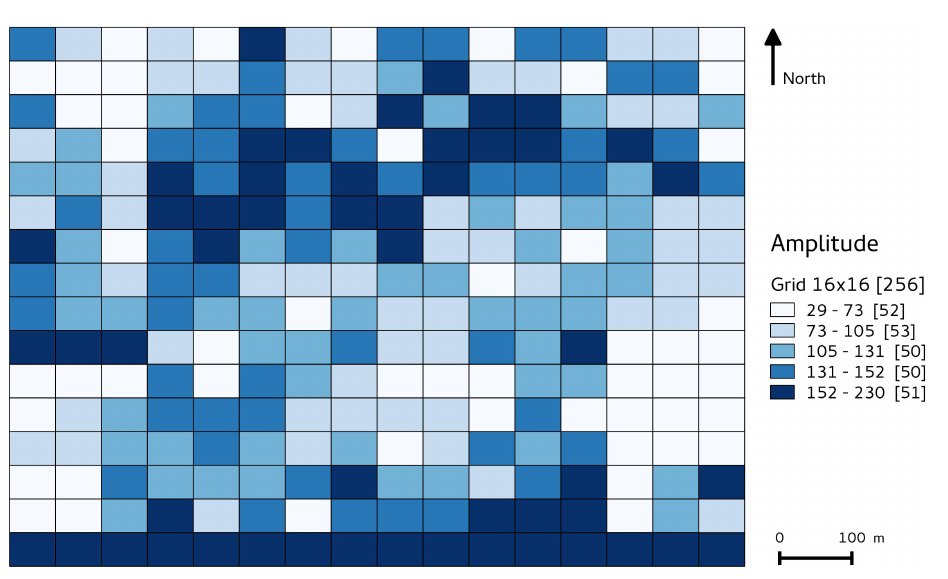
Figure 7. Median of the pixel value maximum amplitude in rectangles; grid 16 × 16 with 256